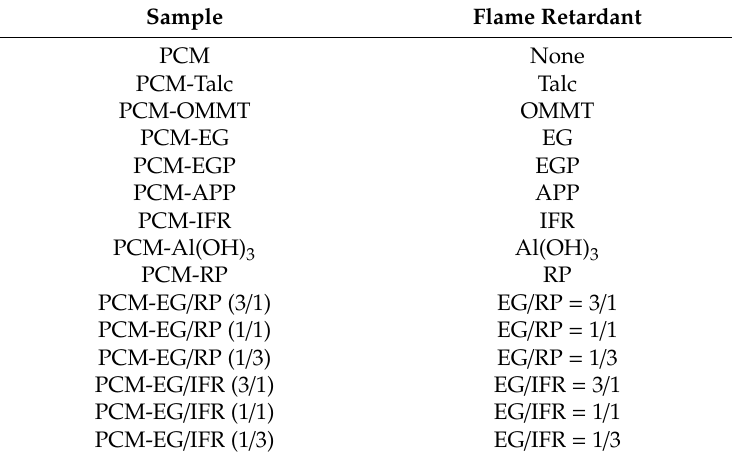
Table 4. Compositions of surface-coated